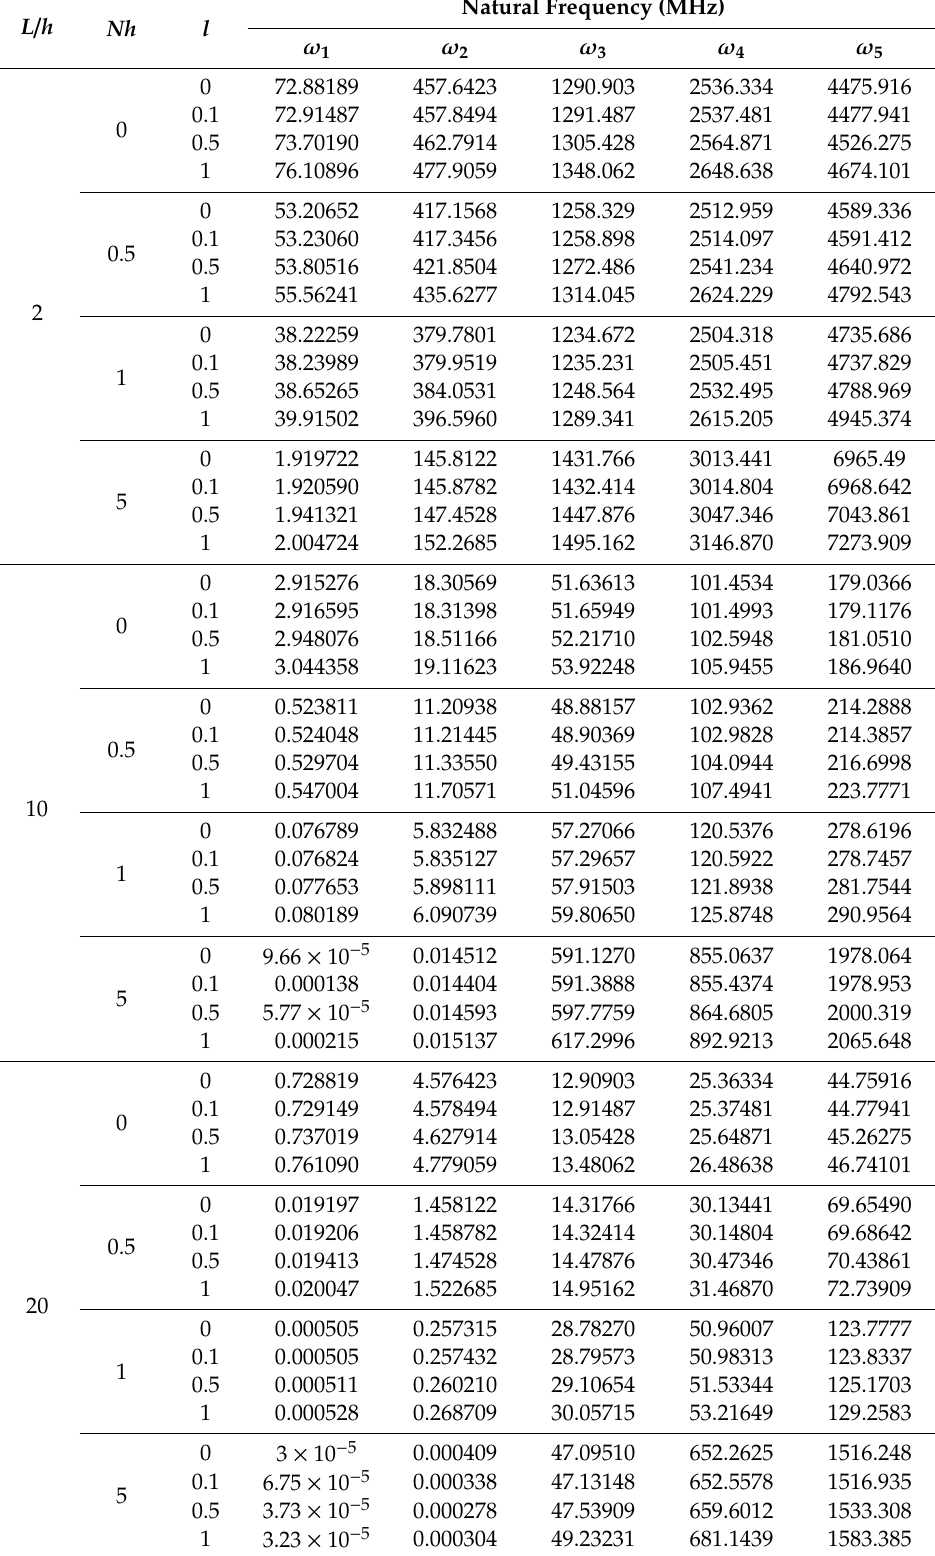
Table 4. Natural frequency of the C-F three-layer [90 ◦ ,0 ◦ ,90 ◦ ] Euler–Bernoulli